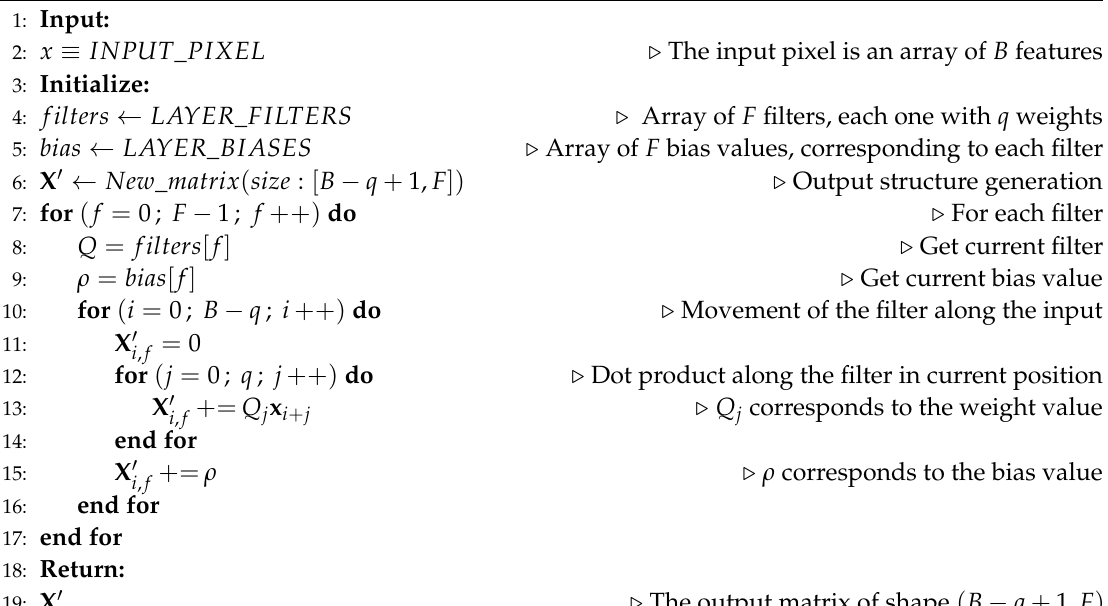
Algorithm 1 1D convolutional layer